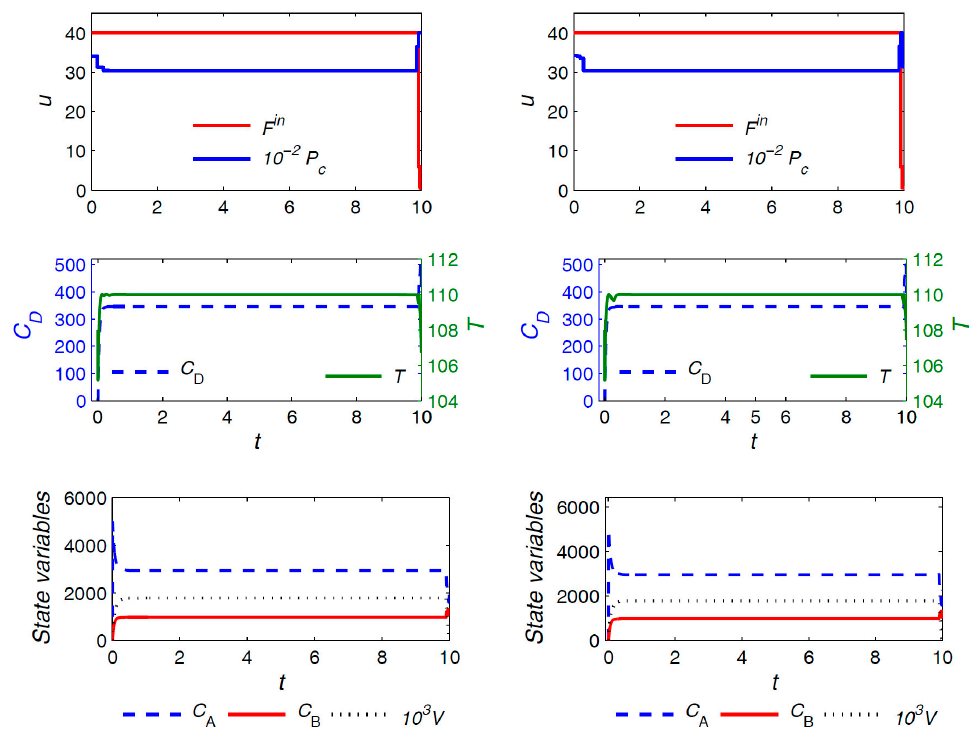
Figure 8. Optimal trajectories for Problem (40) in the case of the main ( left ) and the variant ( right ) formulations of the proposed approach with N = 7